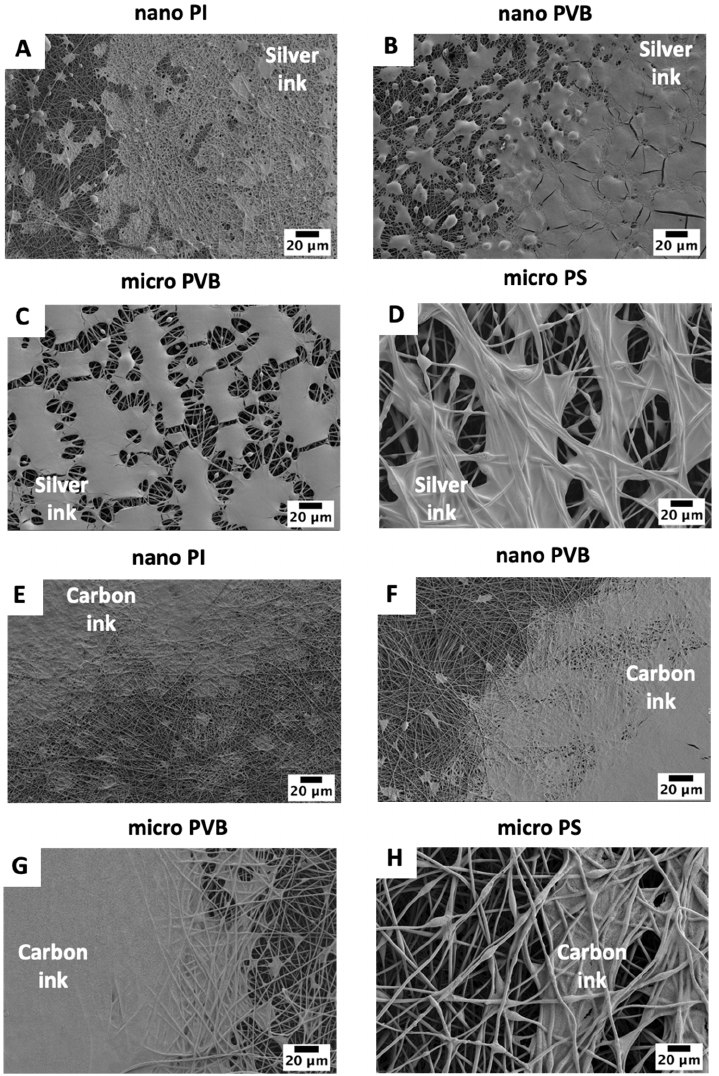
Figure 3. SEM micrographs of electrospun membranes: ( A , E ) nano PI and ( B , F ) nano PVB, ( C , G ) micro PVB and ( D , H ) micro PS printed with two layers of silver and carbon ink, respectively. All pictures were taken after sample sintering.